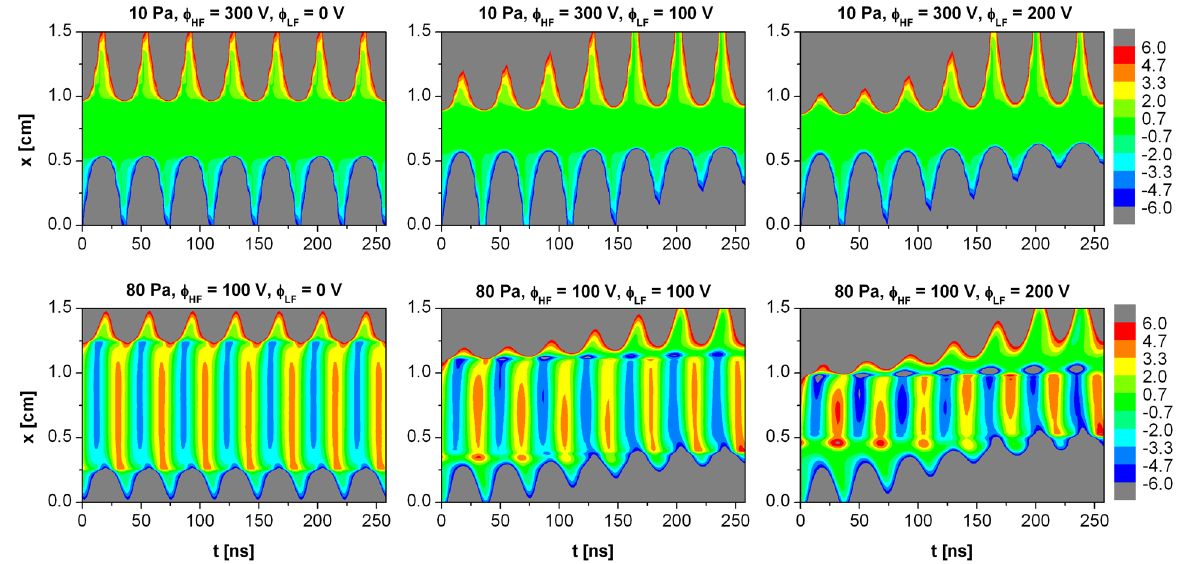
Figure 3 : Spatio-temporal distribution of the electric field in classical dual-frequency discharges operated at 1.937 MHz + 27.12 MHz for different values of the low-frequency voltage amplitude, Φ , at 10 Pa (first row) and at 80 Pa (second row). First column: Φ LF column: Φ =100 V. Third column: Φ =200 V. Φ =300 V at 10 Pa. Φ =100 V at 80 Pa. The color scales are given in 10 3 Vm -1 and apply to all plots LF LF HF HF in the same row. The horizontal axis corresponds to half of the LF period. The vertical axis shows the distance from the powered electrode.